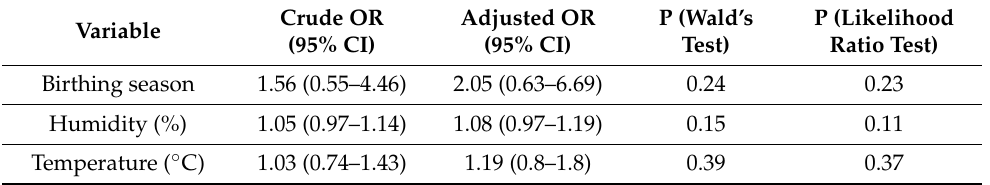
Table 1. Multivariable logistic regression predicting positive sampling event. Positive sampling event means that at least one of the five samples collected tested positive for viral RNA. Birthing season was the time when new births were detected in 2019 (March–September); temperature and humidity were recorded in the cage at the time of sampling. OR = odds ratio, CI = confidence intervals. Crude OR Adjusted OR P (Wald’s P (Likelihood Variable (95% CI) (95% CI) Test) Ratio Test) Birthing season 1.56 (0.55–4.46) 0.23 Humidity